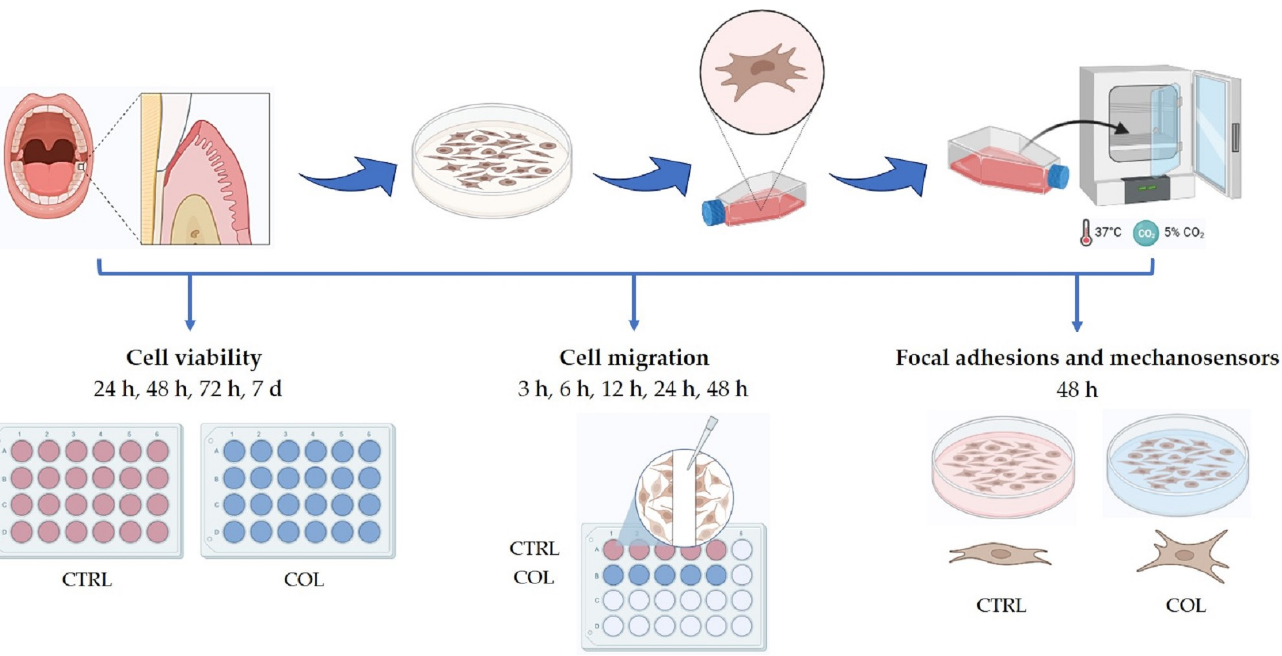
Figure 1. Study design summarizing the experimental conditions and treatments. CTRL: hGF cultured in standard conditions with culture medium. COL: hGF cultured in test conditions on a collagen coating with culture medium. Hours (h), days (d).